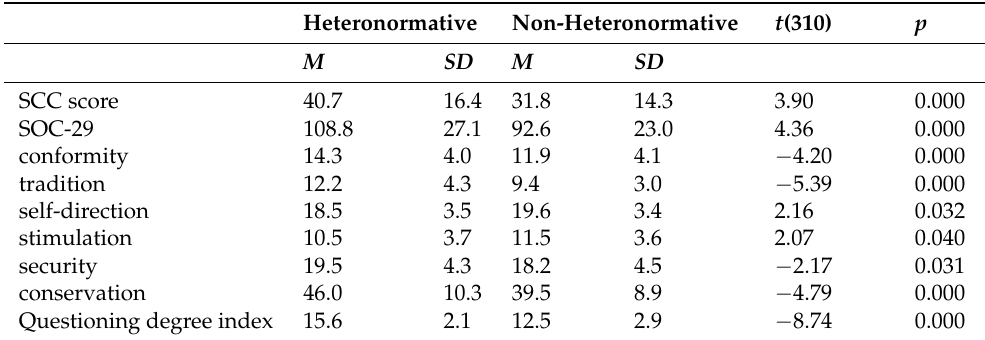
Table 5. Differences between heteronormative and non-heteronormative people.